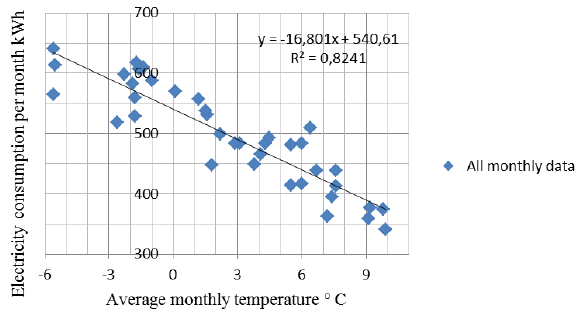
Fig.4. All monthly